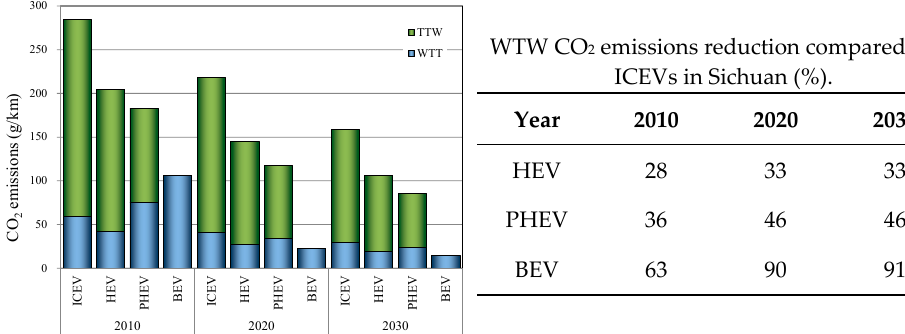
Figure 11. WTW CO 2 emissions of ICEVs/HEVs/PHEVs/BEVs in Inner Mongolia.